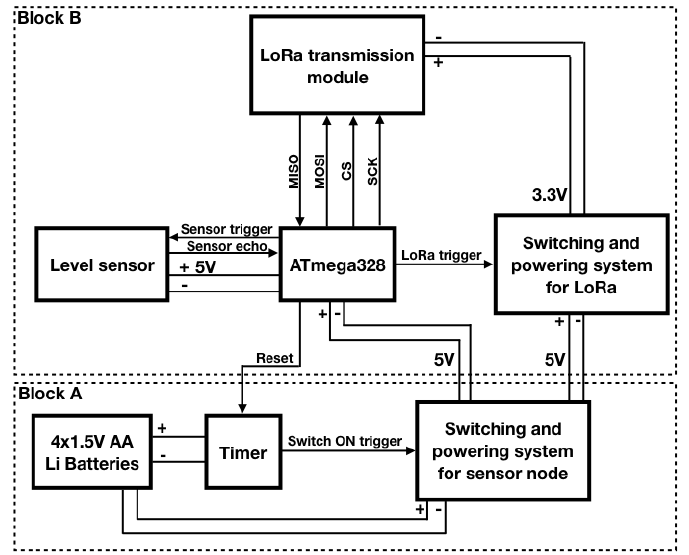
Figure 1. Block diagram of the proposed IoT